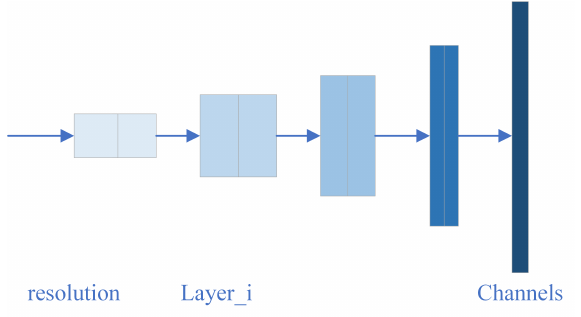
Figure 7. Network structure of Efficientnet